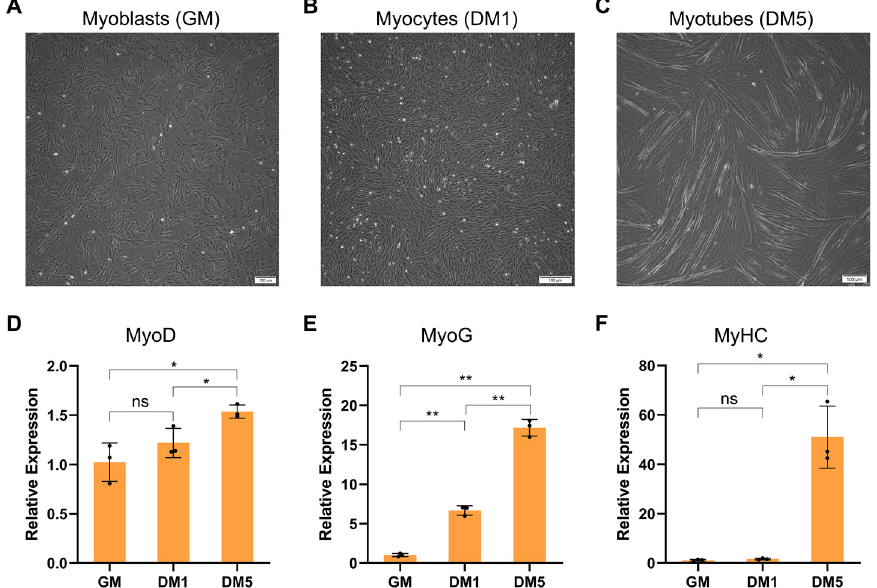
Figure 1. Morphological and gene expression characteristics of proliferating and differentiating goat MuSCs in vitro. ( A ) MuSCs were cultured in the growth medium until they achieved 80% confluence (GM, myoblasts). ( B ) MuSCs were cultured in the differentiation medium for 1 day (DM1, myocytes). ( C ) MuSCs were cultured in the differentiation medium for 5 days (DM5, myotubes). Scale bars = 100 µ m. ( D – F ) Expression profiles of MyoD, MyoG, and MyHC from proliferation (GM) to differentiation (DM1 and DM5) in MuSCs. Data are the means ± SEM. * p < 0.05, ** p < 0.01.